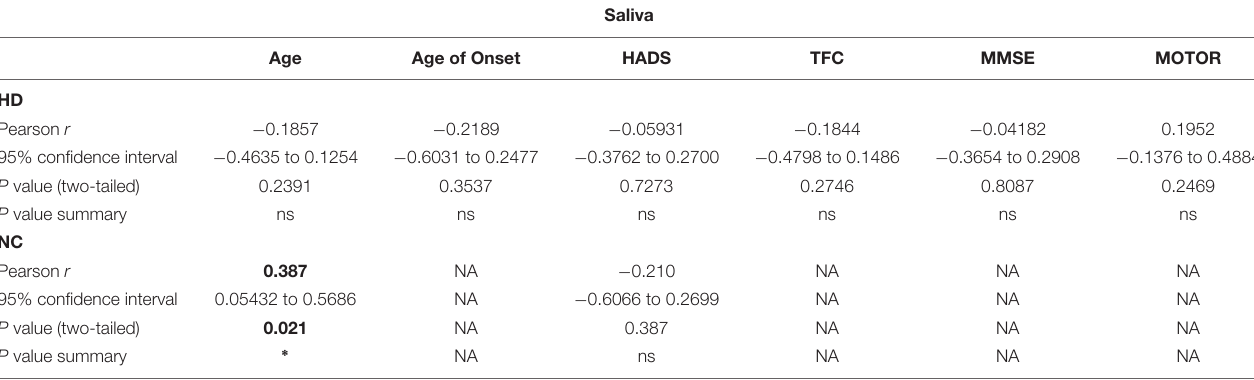
TABLE 3 | Correlations between salivary BDNF levels and clinical data.